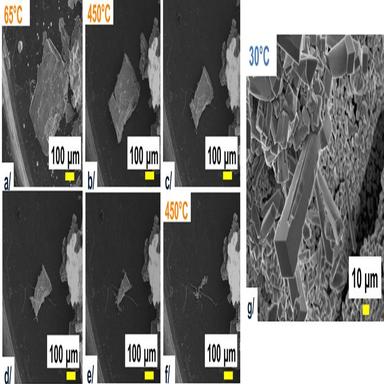
a/−f/ Highlight on the LiBr grain sublimation at 450 °C and g/related LiBr crystallisation on the edge of the stainless steel protection above the crucible.